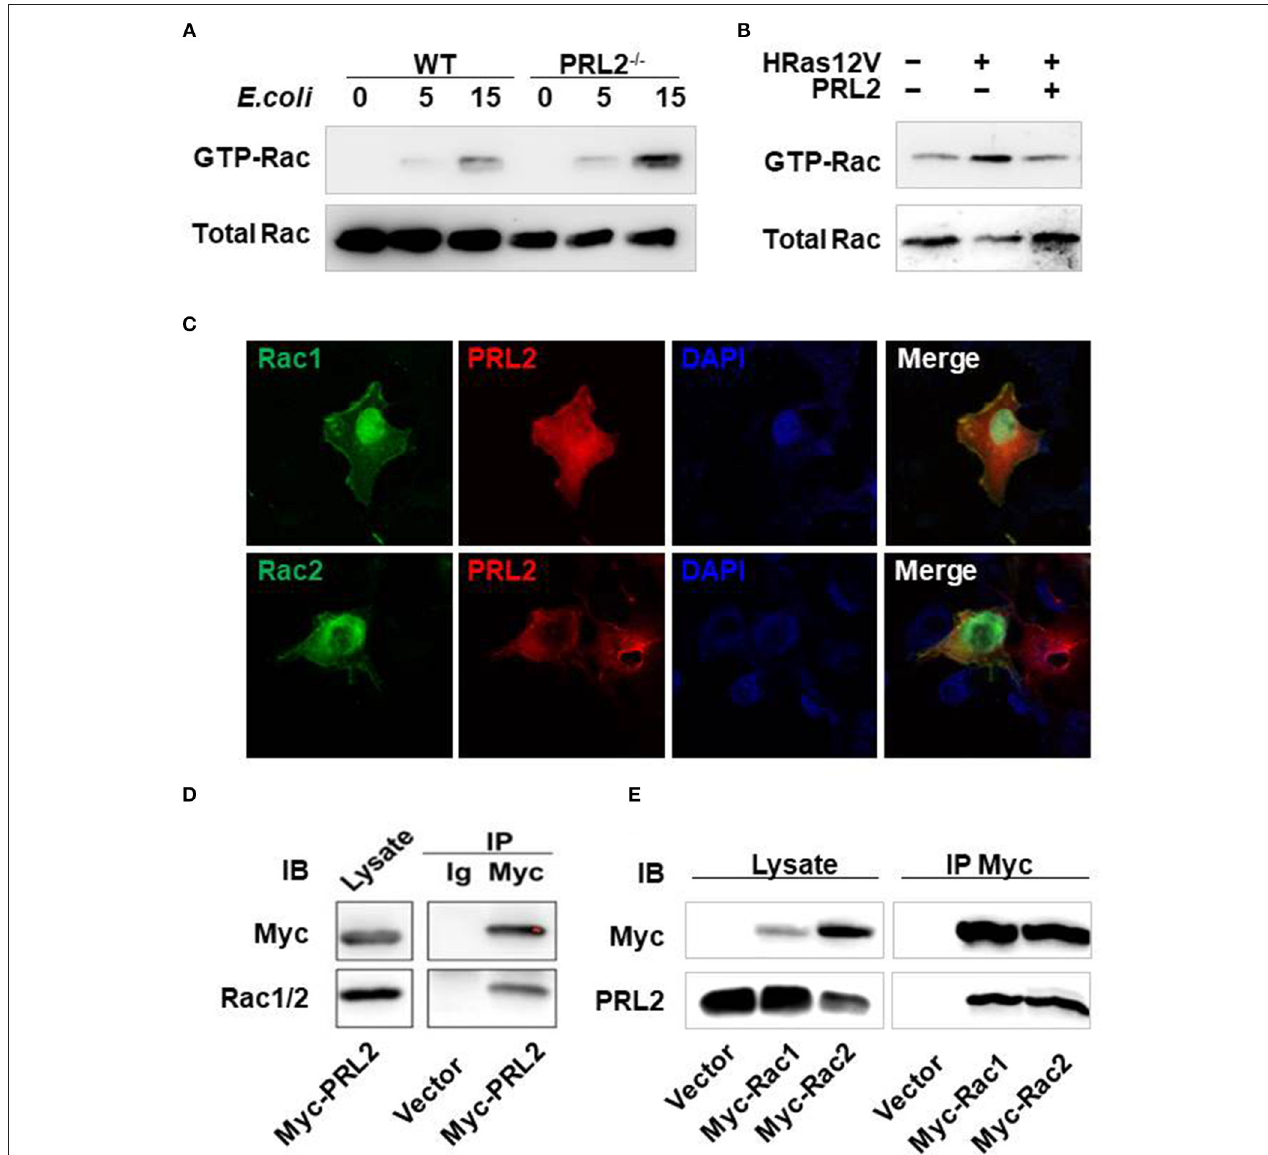
FIGURE 6 | PRL2 binds to, and regulates the activity of, Rac GTPase. (A) WT or PRL2 − / − BMDMs were treated with E.coli (MOI = 10, bacteria vs. cell) for the indicated times. Cell lysates were subjected to pull-down using PAK GST beads. Lysate from pull-down and total lysate were subjected to SDS-PAGE followed by immunoblot assay with anti-Rac antibody. The experiments were repeated 2 times with similar results. (B) 293T cell was transfected with HRas12V or HRas12V and PRL2 for 8 hours. Active and total Rac was detected as above. The experiments were repeated 2 times with similar results. (C) COS7 cells on chamber slides were co-transfected with Rac1-EGFP, Rac2-EGFP and Myc-PRL2 and stained with anti-Myc Alexa 647 antibody (red). Images are representative of two independent experiments. (D) Lysate of 293T cells transiently transfected with Myc–PRL2 pRK5 constructs were immunoprecipitated with anti-Myc beads or anti-IgG beads. Immunoprecipitates and total cell lysate were subjected to SDS-PAGE for western blot. (E) 293T cells were transfected with pRK5 vector or expression plasmids for Myc-tagged Rac1 or Rac2. Cell lysates were collected for co-immunoprecipitation with anti-Myc beads 24h post transfection. Immunoprecipitates and total cell lysates were treated as above. The experiments in panel d and e were repeated at least three times with similar